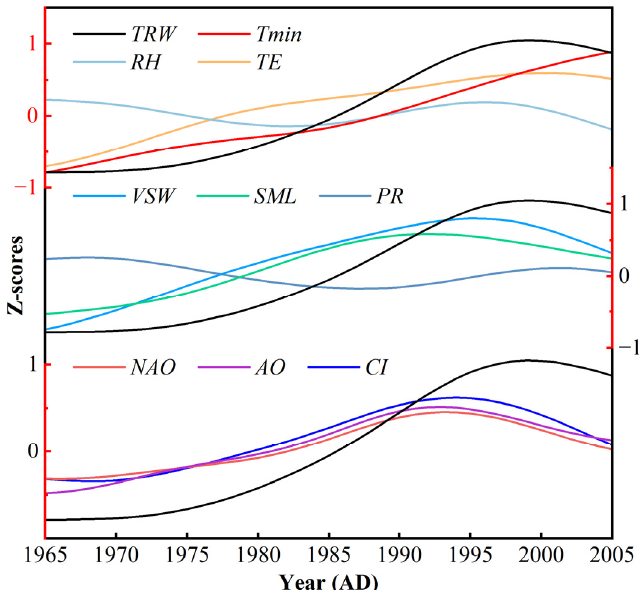
Figure 7. Comparisons between TRW (black line) and climate factors ( Tmin , PR , RH , TE , VSW , SML ) and atmospheric circulation indices (NAO, AO, CI) for 1954–2016 AD. All series were normalised and then subjected to a 21-year low-pass filter.